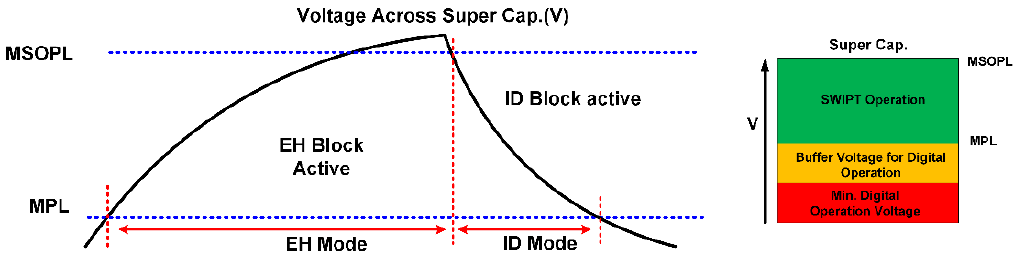
Figure 15. Estimation of the charging and discharging rate of the supercapacitor at the SWIPT transmitter and receiver.